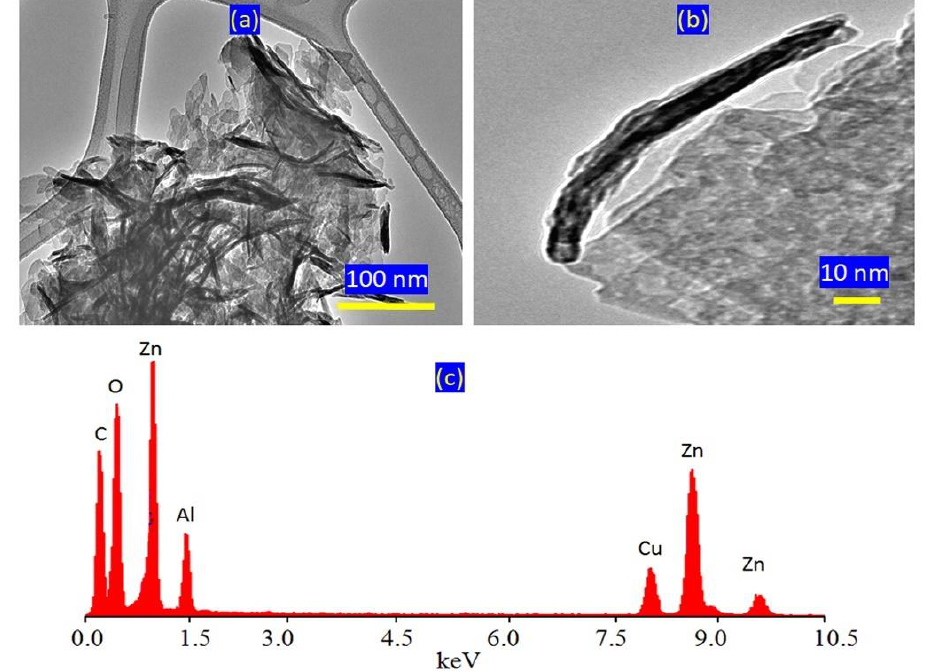
Figure 2. Sample AZ-1: ( a ) TEM image at 100 nm, ( b ) TEM image at 10 nm and ( c ) EDX spectrum.